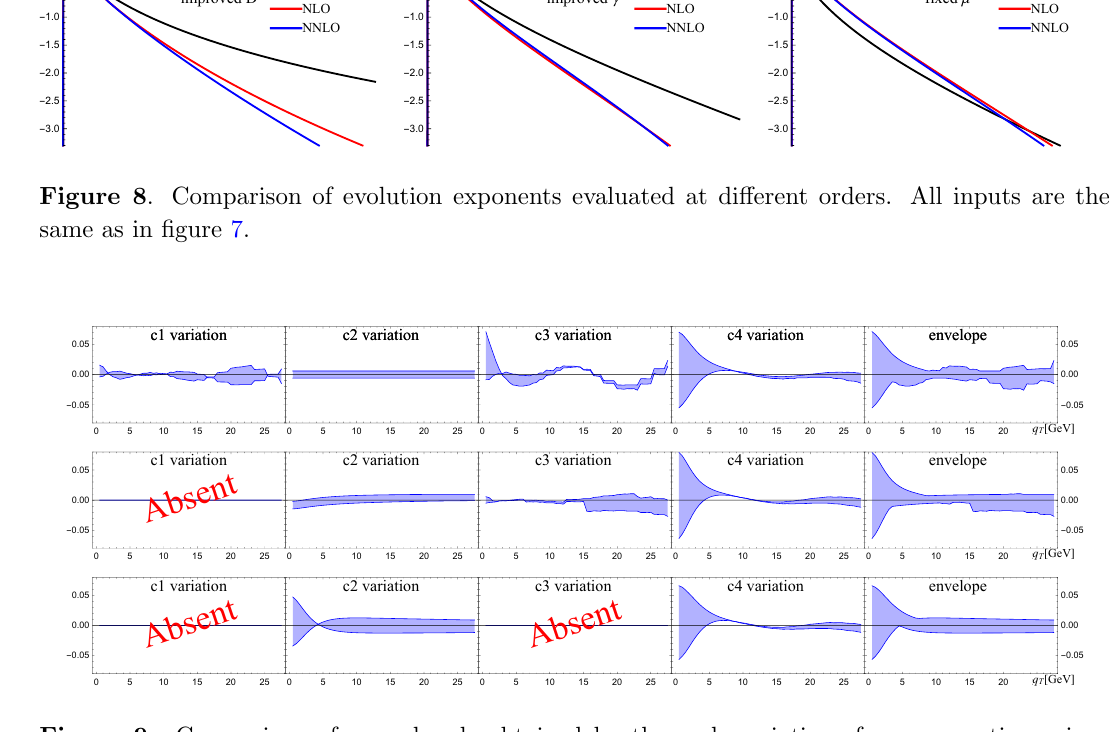
Figure 9 . Comparison of error bands obtained by the scale-variations for cross-sections given by (6.2) (top), (6.5) (middle), (6.12) (bottom) at NNLO. Here, the kinematics bin-integration, etc., is for the Z-boson production measure at ATLAS at 8 TeV